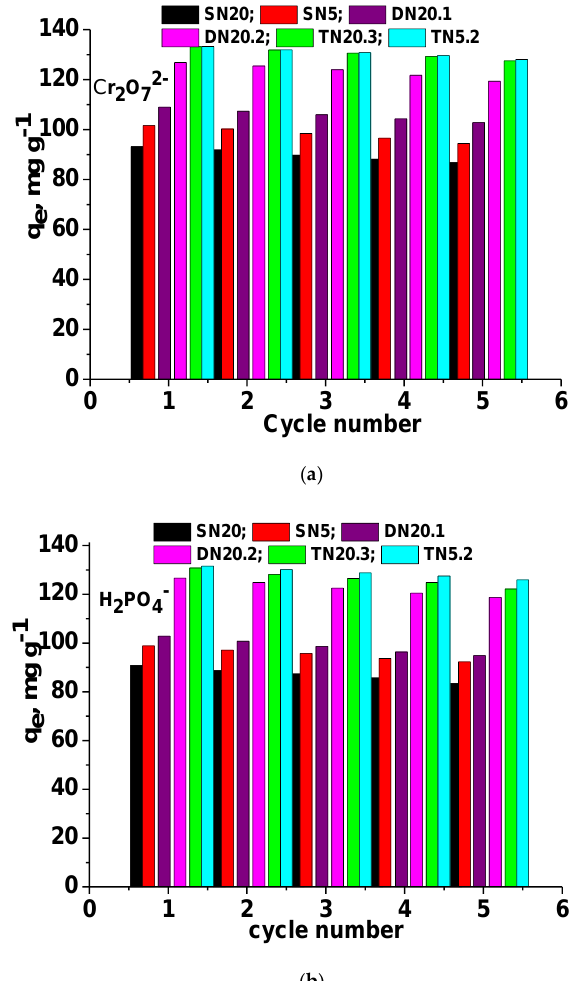
Figure 7. Sorption capacity of Cr 2 O 7 2 − ( a ) and H 2 PO 4 — ( b ) oxyanions onto SN, DN and TN cryogels as a function of the adsorption/desorption cycle number. The increase in the sustainability with the increase in the network numbers is ob- vious for both oxyanions (TN compared with DN sponges).